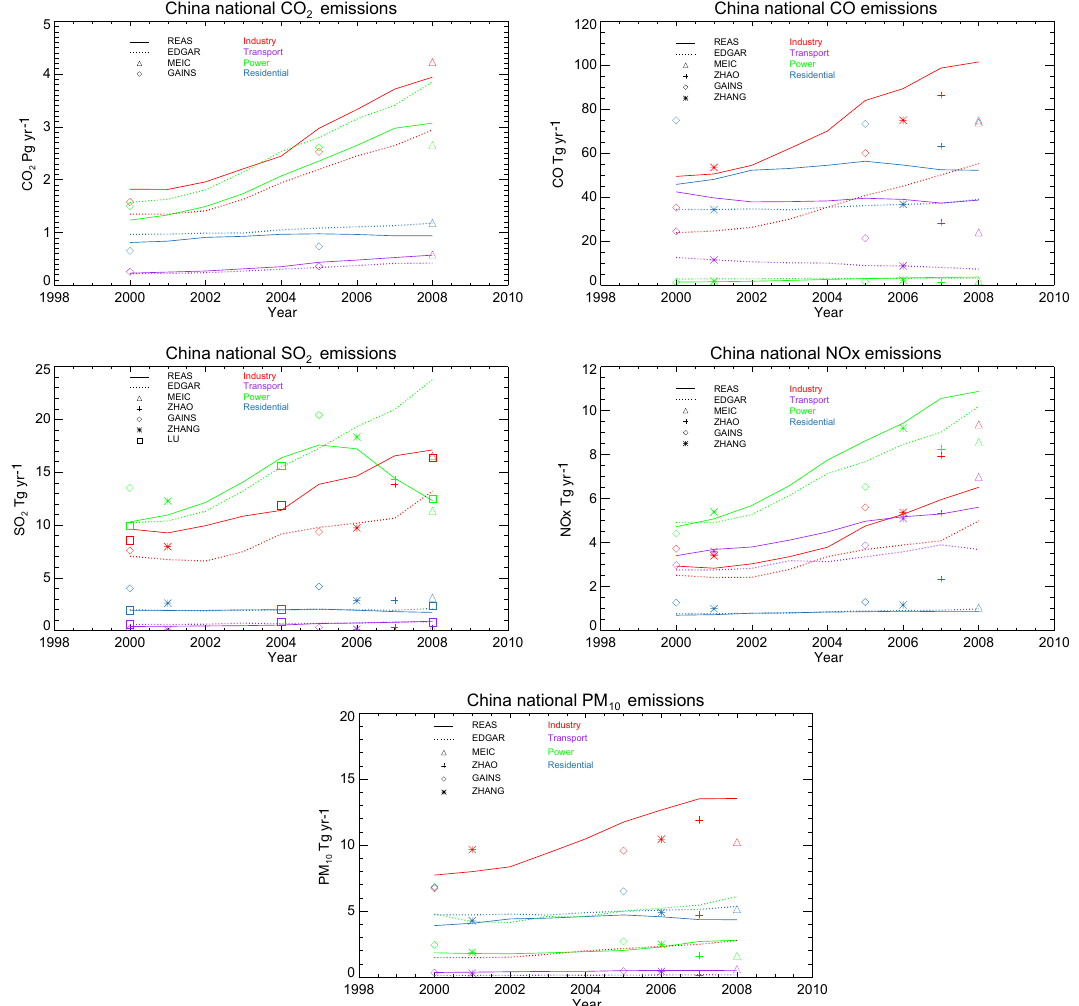
Figure 3. National emissions estimates for CO 2 , CO, SO 2 , NO x , and PM 10 by source sector estimated by REAS, EDGAR, MEIC, ZHAO, and GAINS between 2000 and 2008. Zhang et al. (2009) and Lu et al. (2011) estimates are also included where possible.